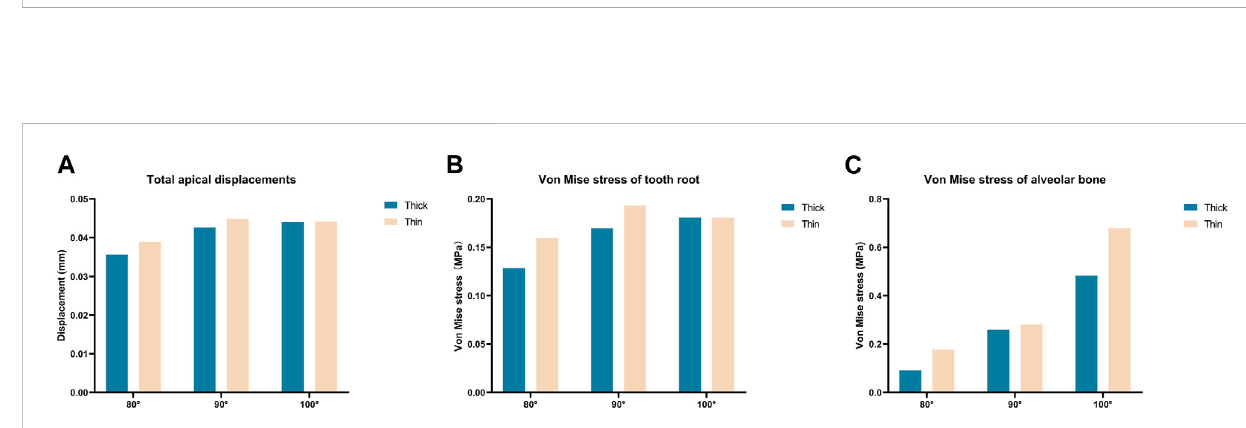
FIGURE 2 Maximum total tooth displacements, maximum von Mise stress on the tooth root and alveolar bone of the central incisor in various models (Thick- 80 ° ; Thick-90 ° ; Thick-100 ° ; Thin-80 ° ; Thin-90 ° ; Thin-100 ° ). (A) Maximum total apical displacements, (B) maximum von Mise stress of the tooth root, and (C) maximum von Mise stress of the alveolar